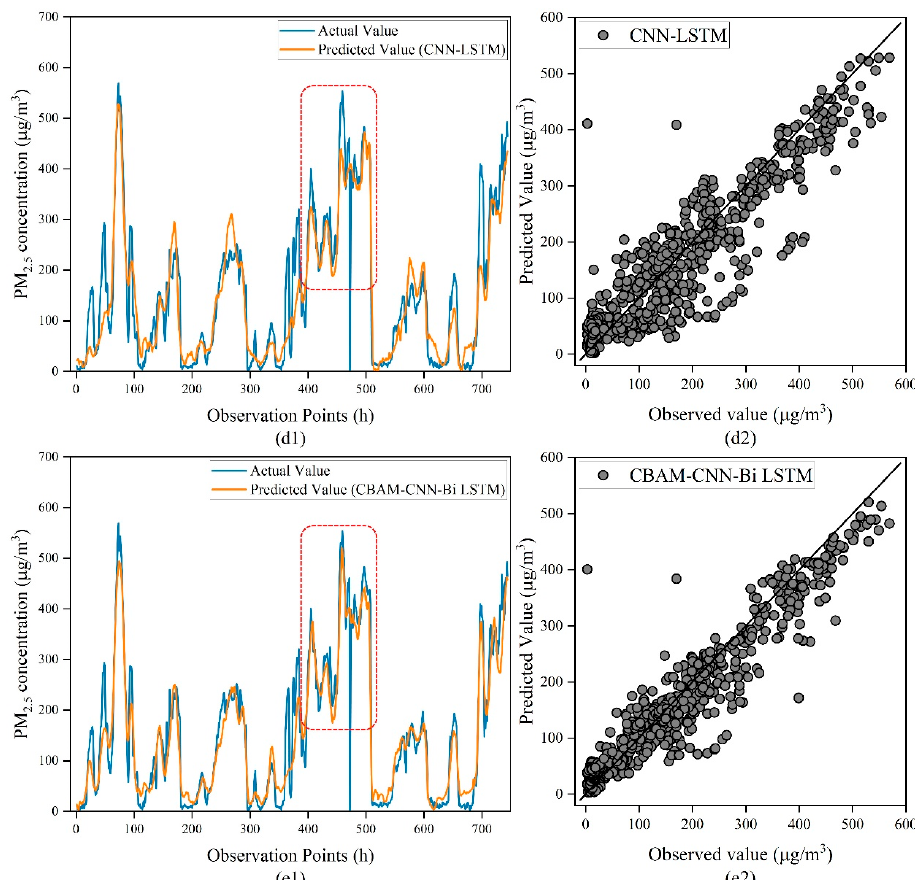
Figure 8. Comparison of PM 2.5 concentration prediction models for the next 48h at station 1001A. ( a1 ) Prediction line graph of CNN model; ( a2 ) Prediction scatter plot of CNN model; ( b1 ) Prediction line graph of LSTM model; ( b2 ) Prediction scatter plot of LSTM model; ( c1 ) Prediction line graph of Bi LSTM model; ( c2 ) Prediction scatter plot of Bi LSTM model; ( d1 ) Prediction line graph of CNN-LSTM model; ( d2 ) Prediction scatter plot of CNN-LSTM model; ( e1 ) Prediction line graph of CBAM-CNN-Bi LSTM model; ( e2 ) Prediction scatter plot of CBAM-CNN-Bi LSTM model.